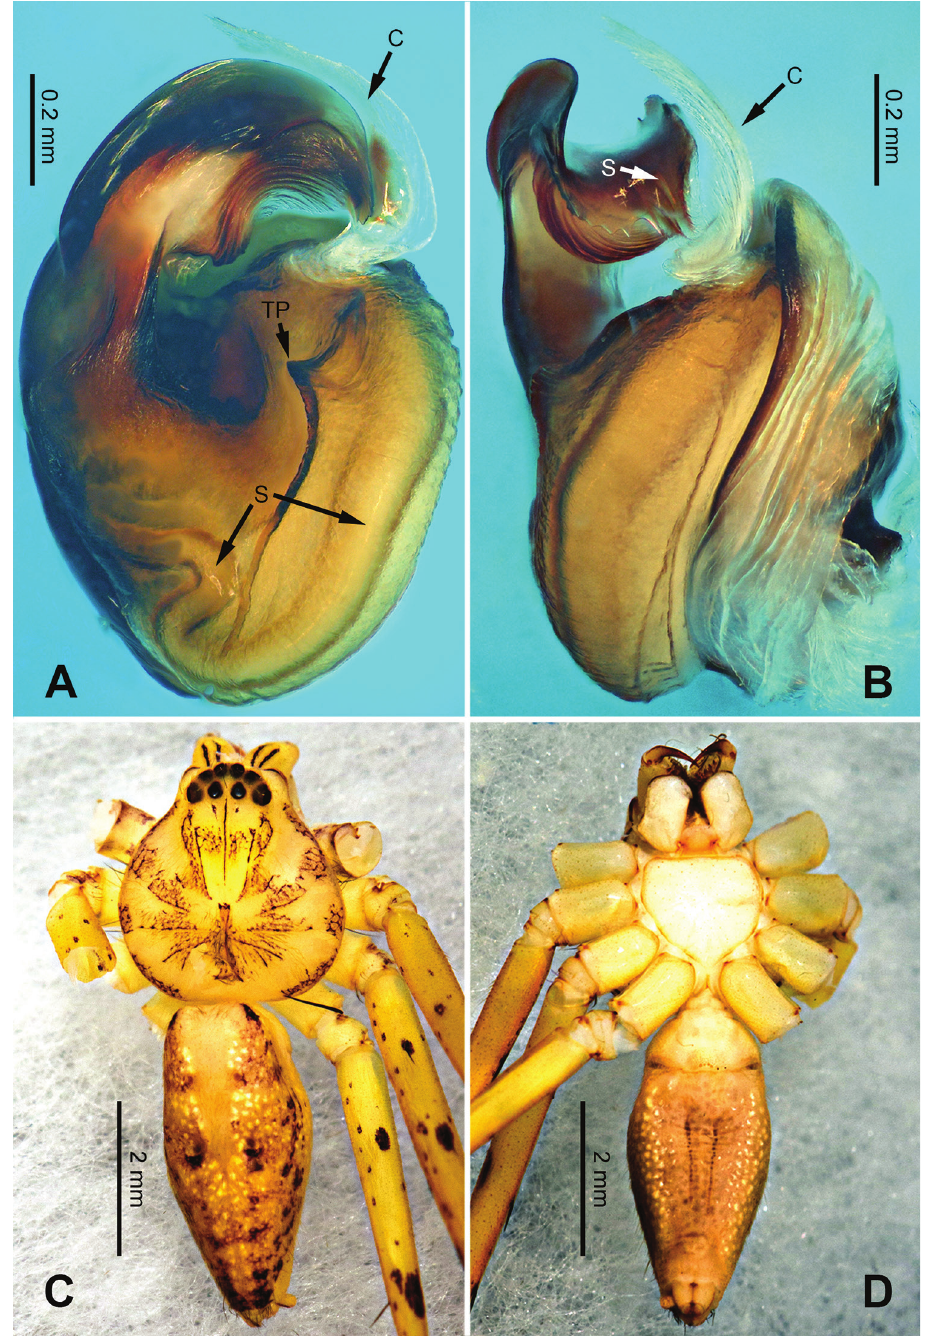
Figure 32. Pseudopoda xia Zhao & Li, sp. n., male holotype. A Bulb, ventral view B Bulb, dorsal view C Habitus, dorsal view D Habitus, ventral